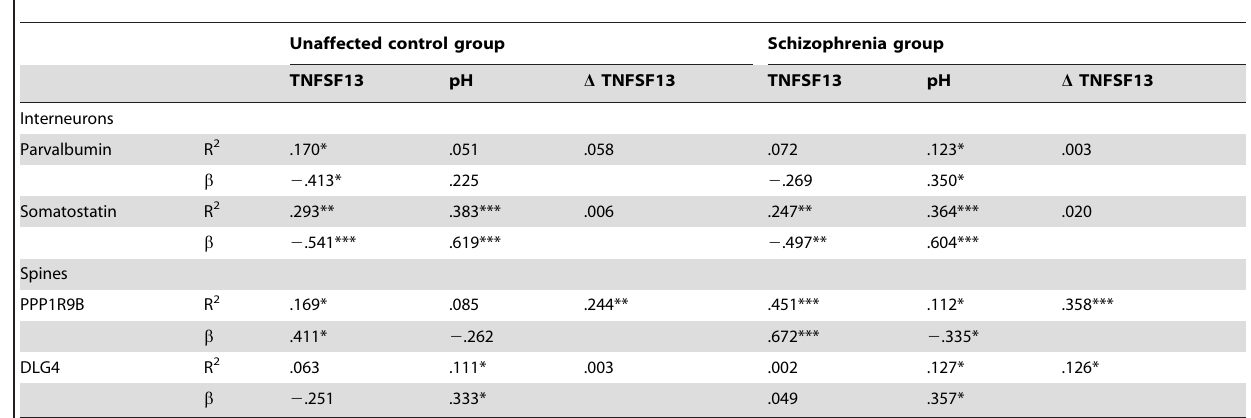
Table 2. Variance (R 2 ) in parvalbumin, somatostatin, PPP1R9B and DLG4 mRNA transcript levels accounted for by TNFSF13 expression and tissue pH in the NSW TRC